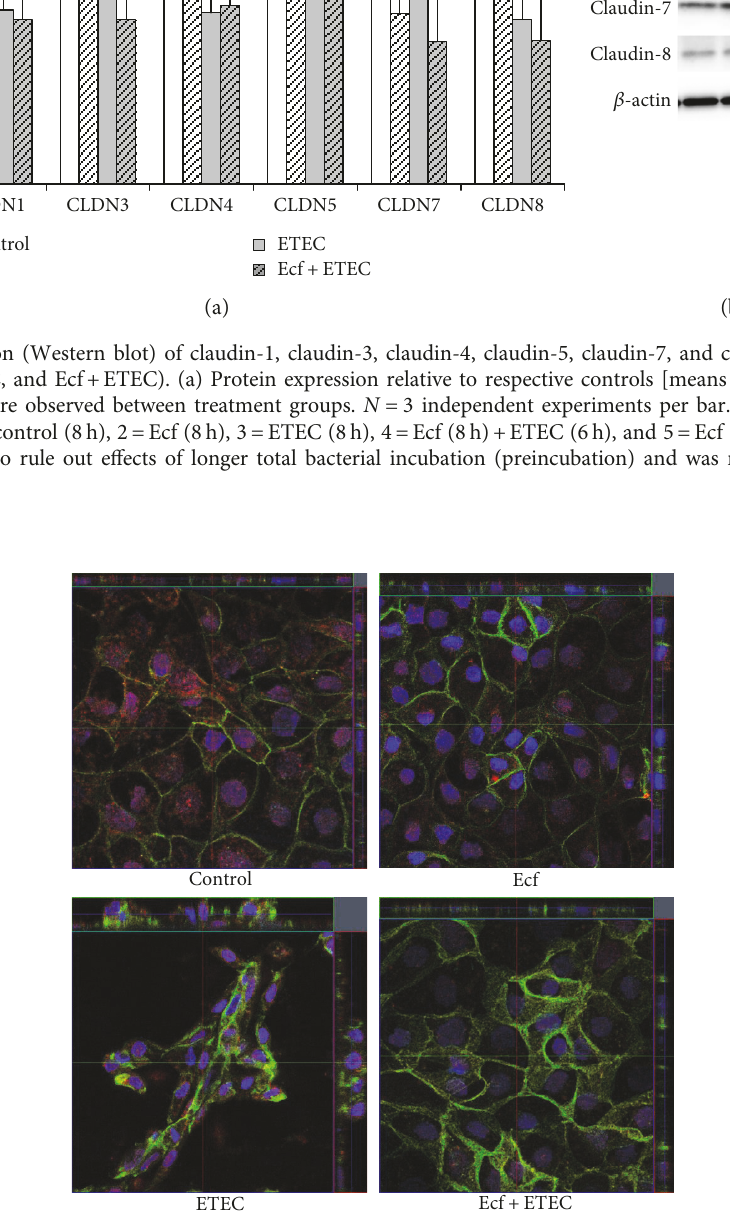
Figure 4: Confocal images of postcon fl uent IPEC-J2 cells at 6 h after treatment with bacterial strains (Ecf, ETEC, and Ecf +ETEC) and controls (red: claudin-3, green: claudin-4). Under all conditions, claudin-4 was localized in the tight junction and in the lateral membrane. N = 5 independent